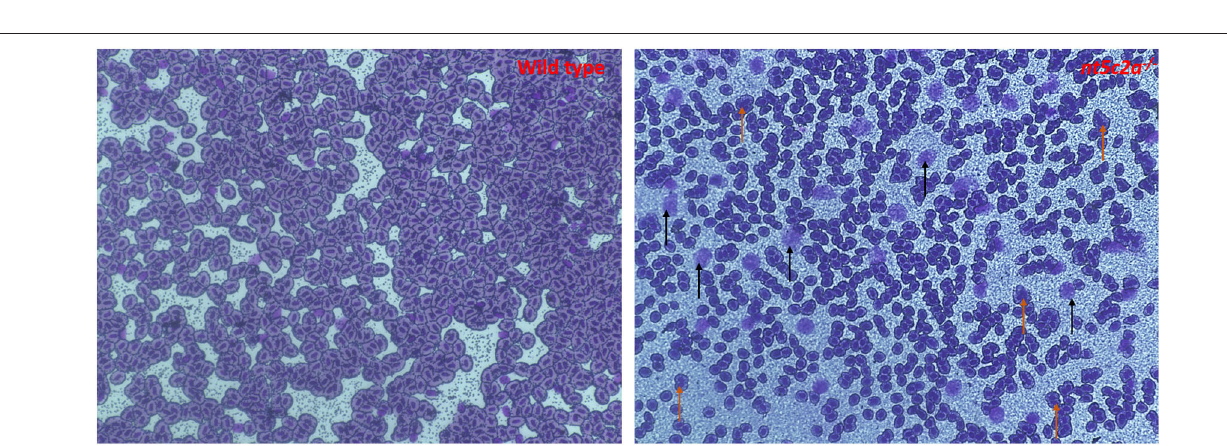
five genes CYP17A1, BORCS7, AS3MT , CNNM2 , and NT5C2